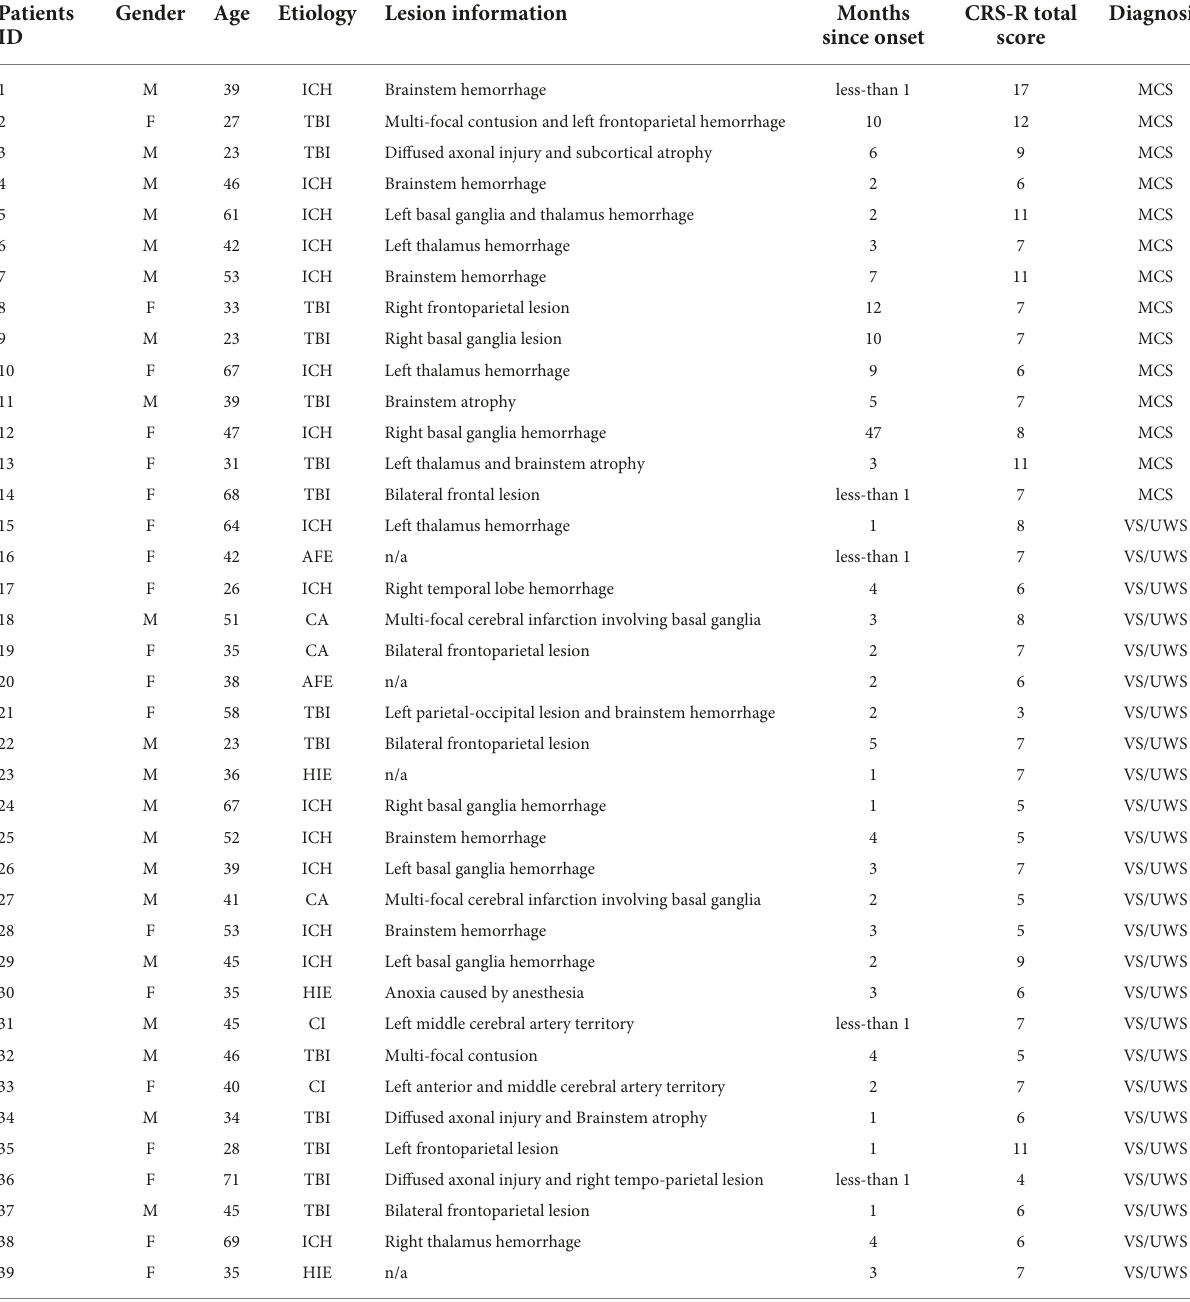
TABLE 1 Demographic and clinical features of DOC patients. Patients